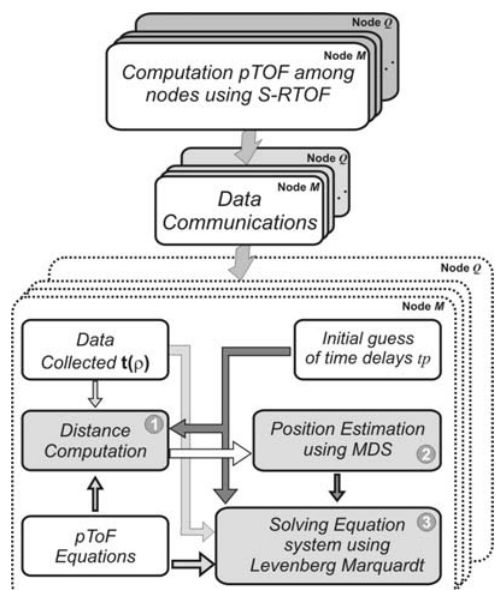
Figure 4. Positioning Algorithm